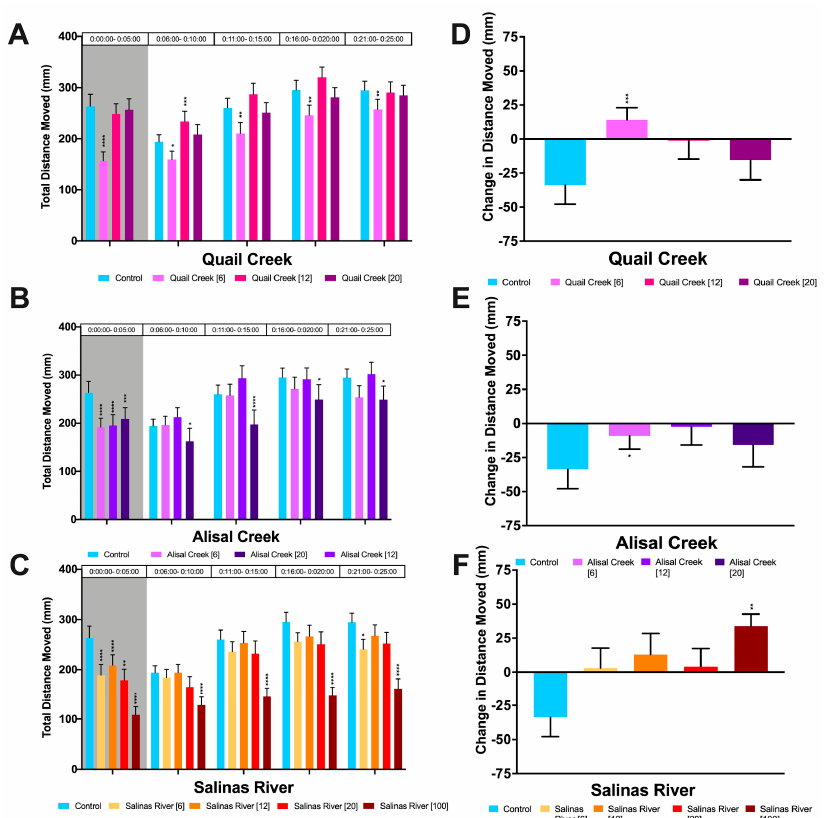
Figure 2. Swimming Behavior of D. magna after Exposure to Water Samples from the Salinas Valley Watershed collected in November 2019 (after first flush). ( A – C ) Average total distance moved (mm) of D. magna after 96 h of exposure to water samples from ( A ) Quail Creek, ( B ) Alisal Creek or ( C ) Salinas River. ( D – F ) Photomotor response of D. magna after 96 h of exposure to water samples from ( D ) Quail Creek, € Alisal Creek, or ( F ) Salinas River calculated by taking the difference between the average distance moved in the last minute of dark and the first minute of light. The significance of Tukey’s Multiple Comparisons tests is shown as * = p ≤ 0.05, ** = p ≤ 0.01, *** = p ≤ 0.001, **** = p ≤ 0.0001. Error bars depict standard error.